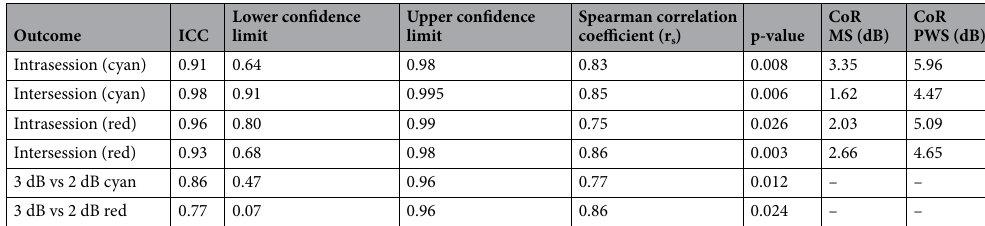
Table 1. Intraclass correlation coefficient (ICC) with 95% confidence intervals (CI), Spearman correlation (rho) and coefficient of repeatability (CoR) for mean sensitivity (MS) and pointwise sensitivity